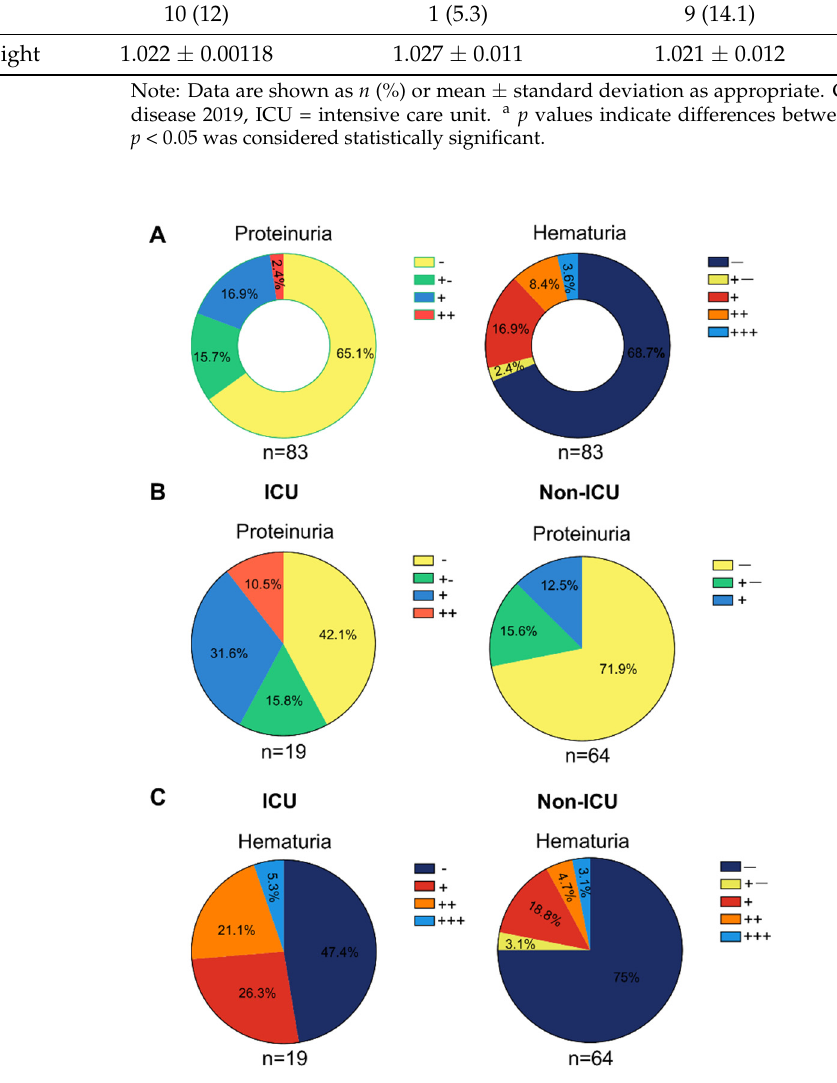
Figure 2. Pie chart illustrating COVID-19 patients exhibited abnormal urinalysis, including pro- teinuria and hematuria. ( A ) Analysis of all the COVID-19 patients with urine routine test. ( B ) Anal- ysis of proteinuria between ICU and non-ICU. ( C ) Analysis of hematuria between ICU and non- ICU.